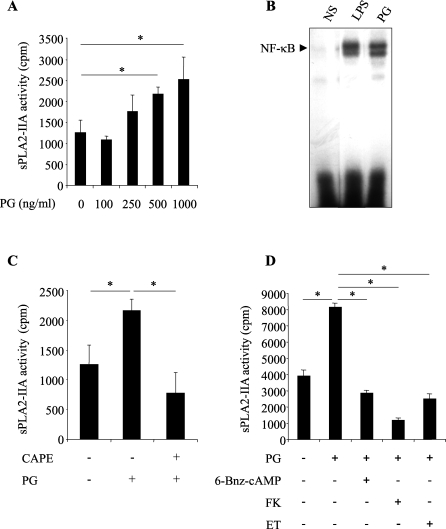

B. anthracis PG Induces sPLA2-IIA Expression(A) After AMs were stimulated overnight with the indicated concentrations of PG, sPLA2-IIA secretion was examined.(B) After a 1-h incubation with PG (500 ng/ml) or LPS (50 ng/ml), the nuclear extracts were obtained and EMSA was performed. NS, not stimulated.(C) AMs were incubated for 1 h with CAPE (10 μM), followed by an overnight stimulation with PG (500 ng/ml).(D) AMs were pretreated with 6-Bnz-cAMP (200 μM), FK (20 μM), or ET (1 μg/ml) for 1 h before overnight stimulation with B. anthracis PG (2 μg/ml). Then, the supernatants were collected to measure sPLA2-IIA secretion.The data are the mean ± SEM and are representative of four experiments. An asterisk (*) indicates p < 0.05.